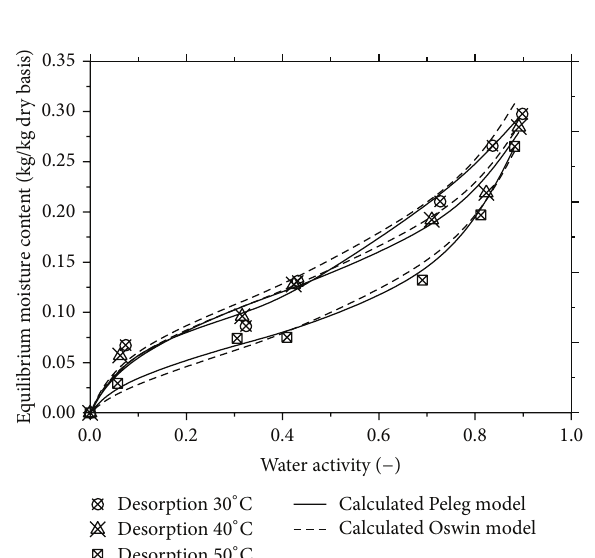
Figure 4: Comparison between experimental and calculated (Peleg and Oswin models) data of desorption isotherms of Ziziphus spina- christi leaves obtained at 30, 40, and 50 ∘ C. Cal.: calculated.